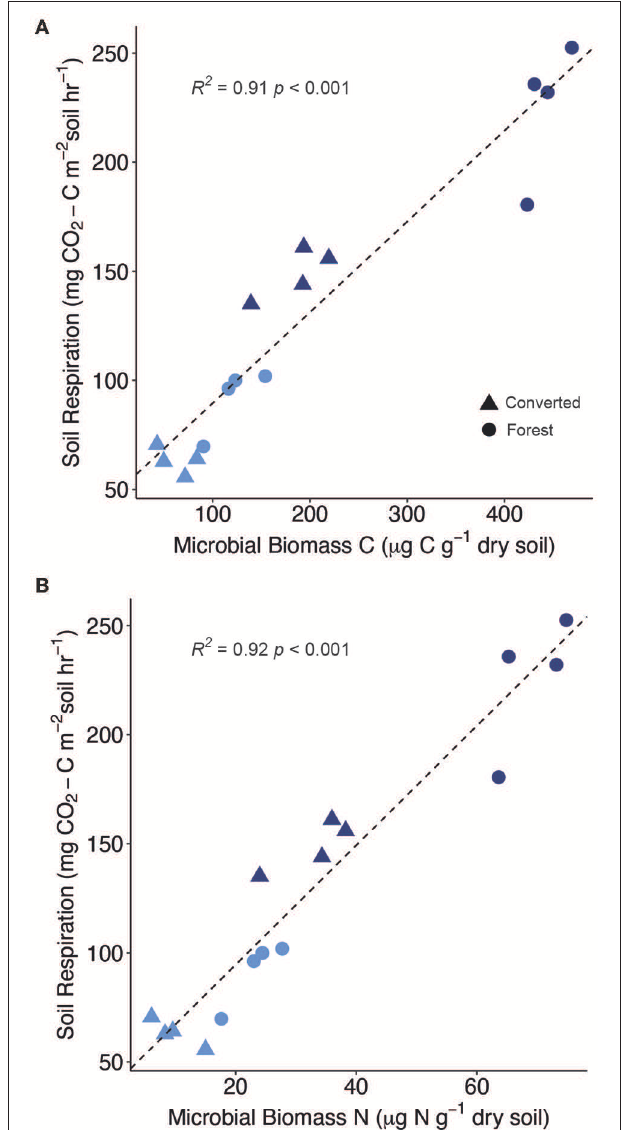
FIGURE 5 | The relationship between mean soil respiration and microbial biomass (A) carbon (C) or (B) nitrogen (N) in tropical forest (circles) or converted habitats (triangles) at SAFE in Malaysian Borneo (pale blue symbols) and BCNM in Panama (dark blue symbols); showing mean values for each litter treatment (bare soil, introduced, secondary forest or primary forest litter), site, and habitat ( n = 4).